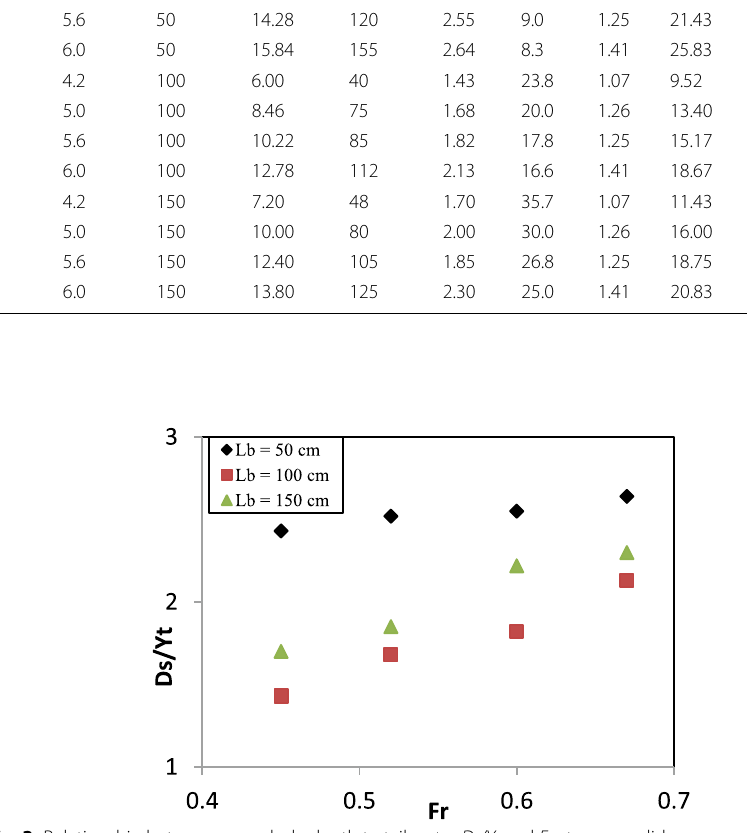
Fig. 3 Relationship between scour hole depth to tail water D s /Y t and Fr at apron solid